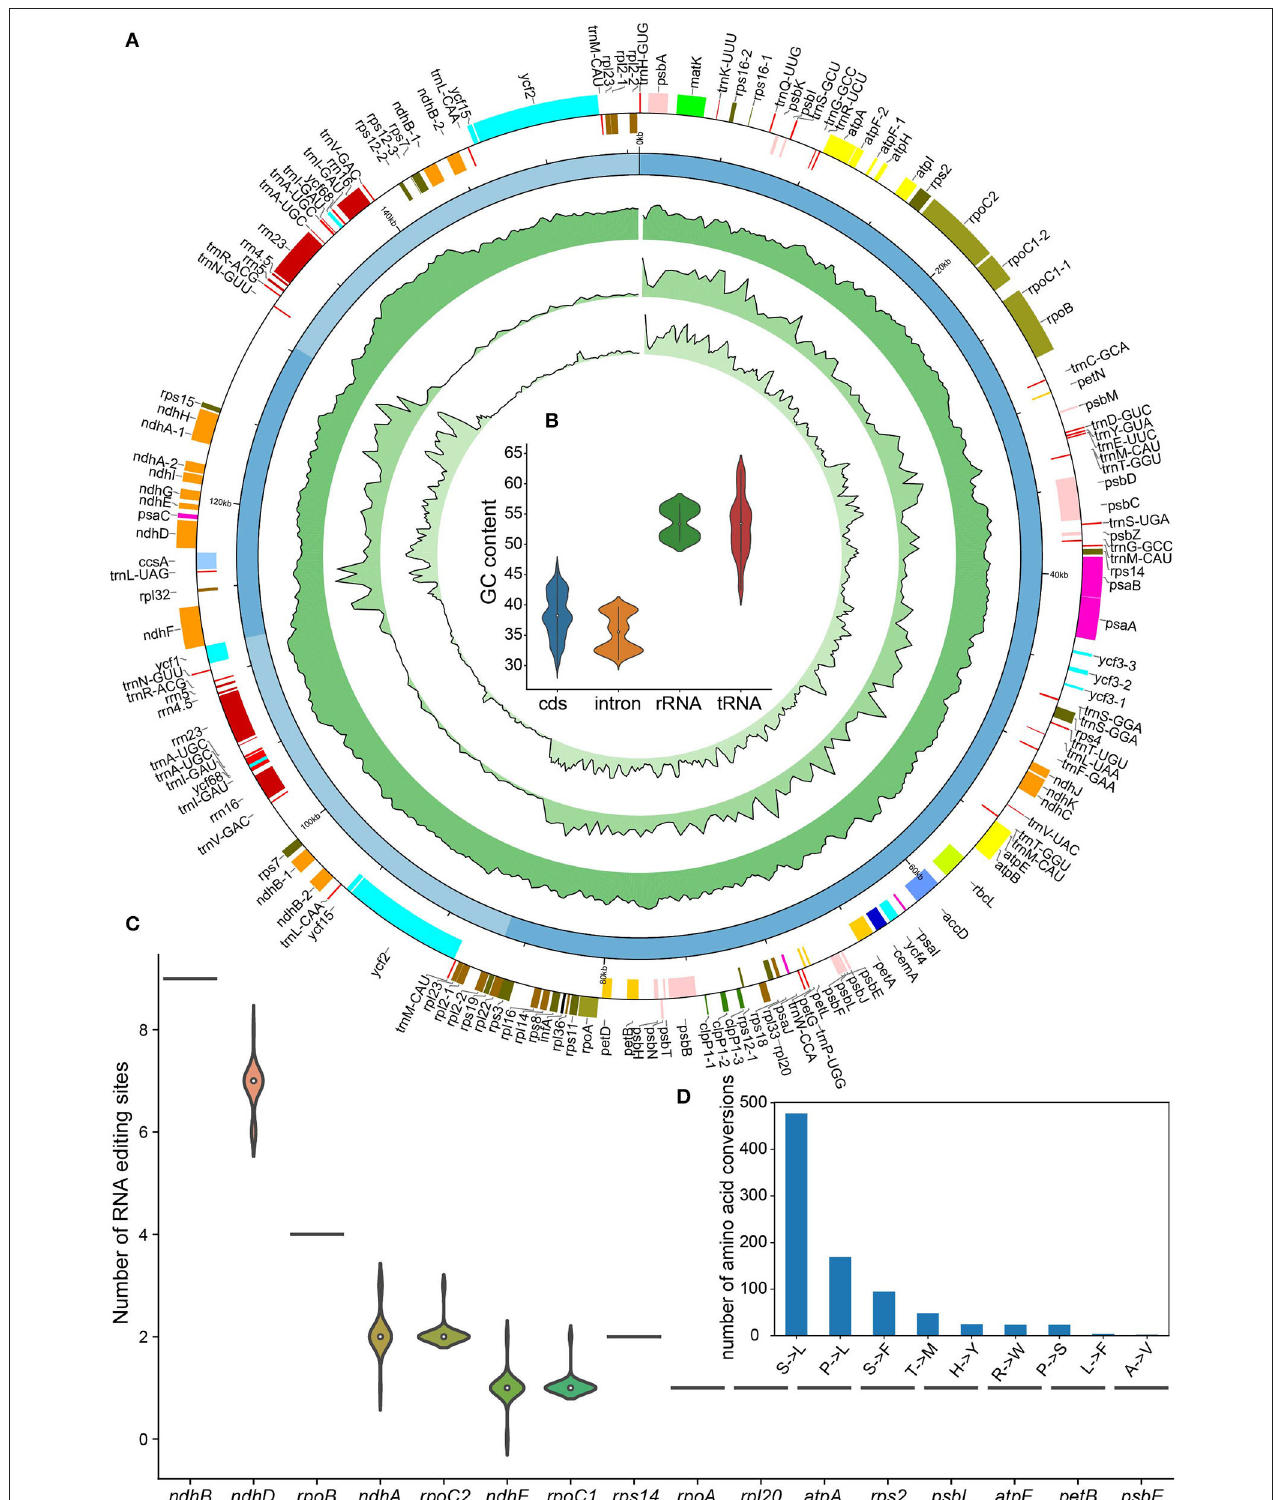
FIGURE 1 | Basic characteristics of the 24 Nicotiana chloroplast genomes. (A) Circos plot showing basic characteristics of the chloroplast genomes acquired in this study. The gene position, quadripartite structure, GC content, density of variant sites, and nucleotide diversity (Pi) were shown from the outer to inner rings. The outermost rectangles were chloroplast genes belonging to different functional groups that were color-coded. Gene blocks shown on the outside and inside the circle were transcribed clockwise and counterclockwise, respectively. (B) The GC content of CDS, intron, tRNA, and rRNA genes among Nicotiana chloroplast genomes. (C) The number of RNA editing sites among genes of chloroplast genomes. (D) The number of amino acid conversions resulting from RNA editing in chloroplast genomes.